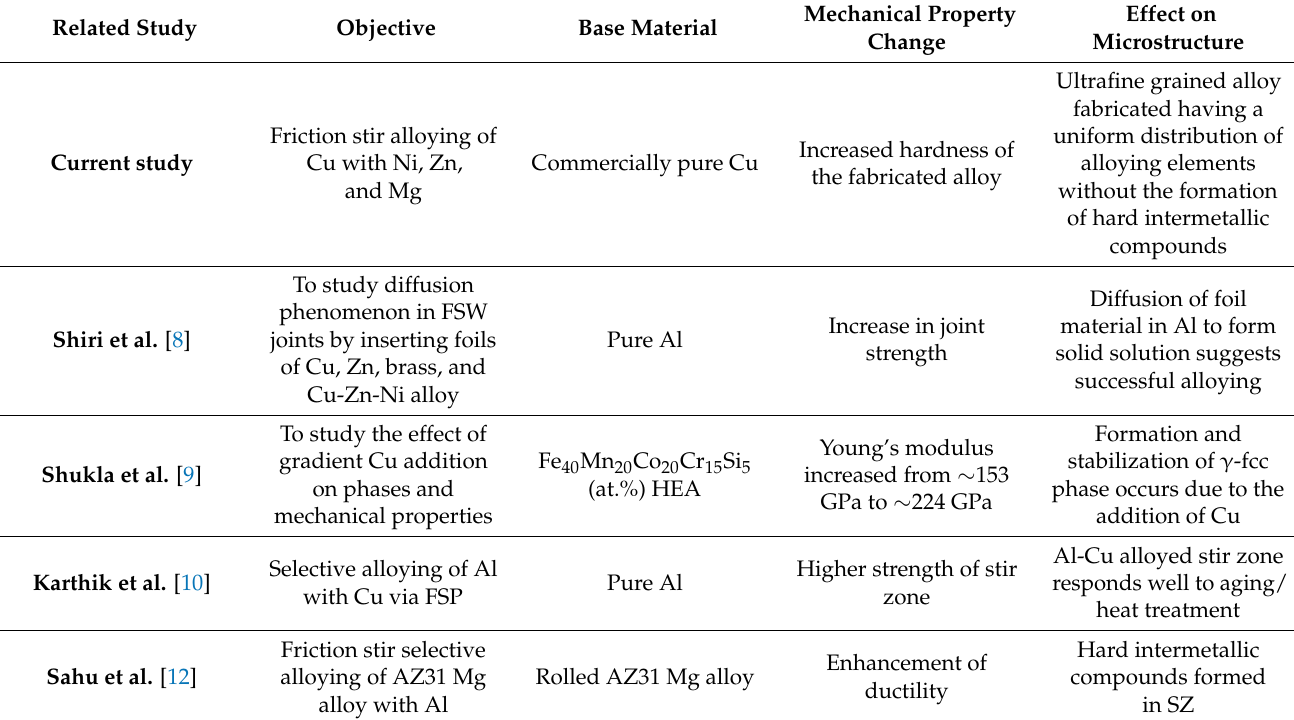
Table 2. Comparison of results with previous work related to FSA.